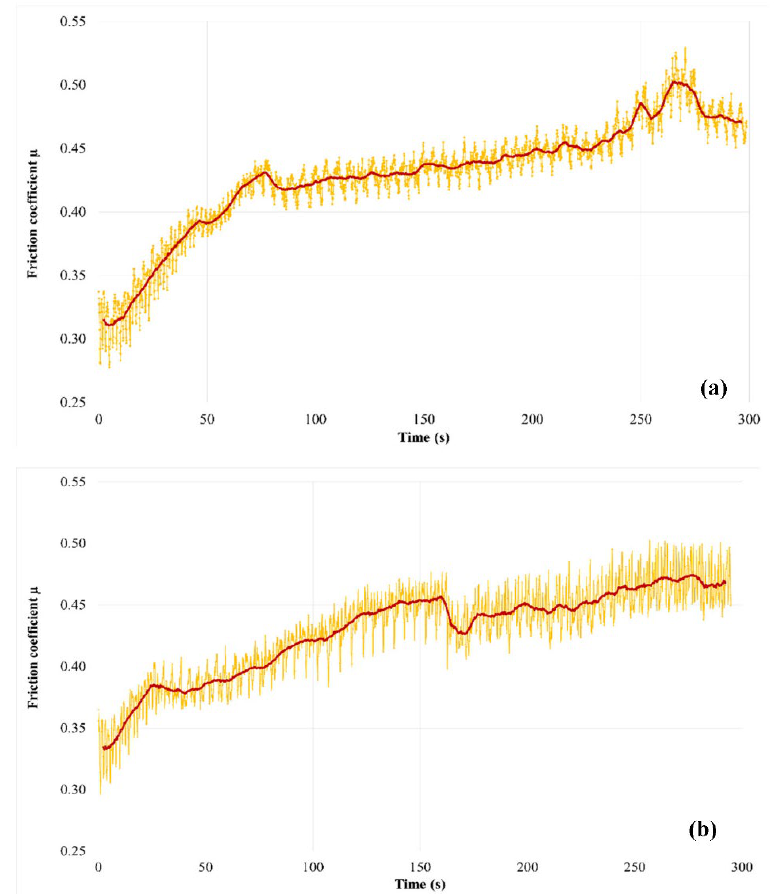
Figure 11. Evolution of the friction coefficient ( µ ) during the friction test for ( a ) M1 and ( b ) M2 (the average value of µ is obtained from a low pass filtering of the force measurements).